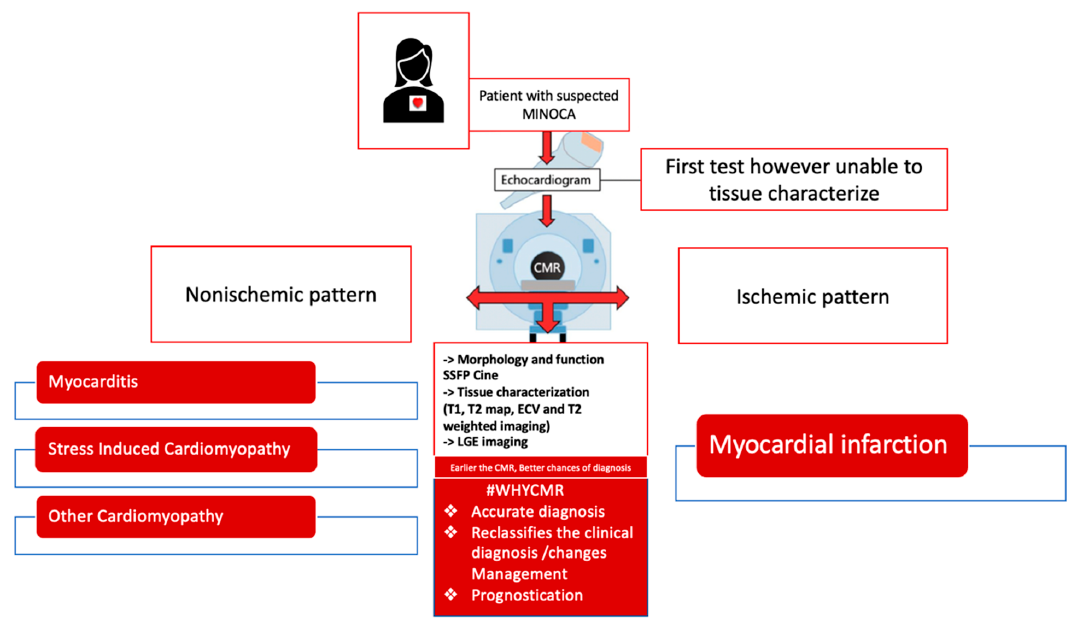
Figure 4. Role of CMR in patients presenting with suspected